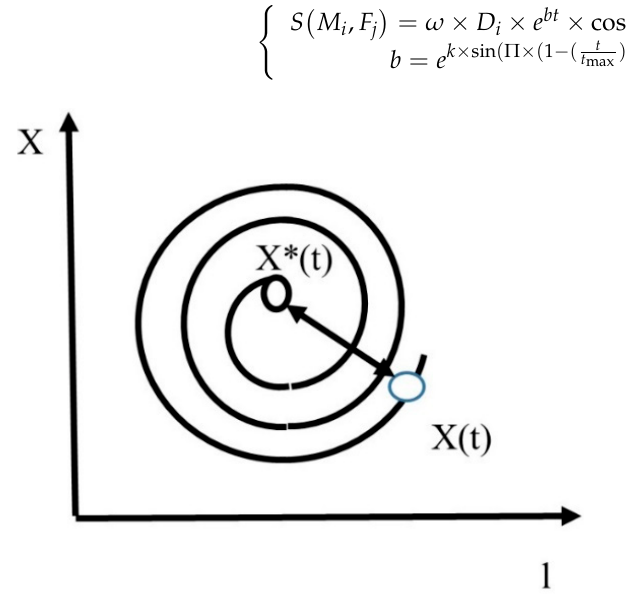
Figure 2. Position variation diagram.